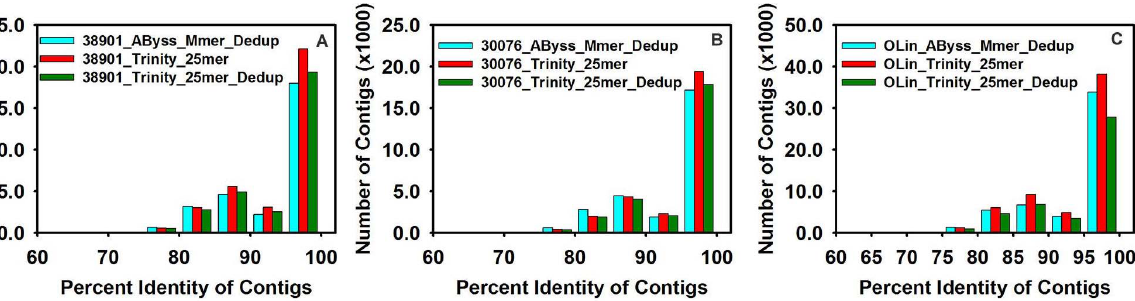
Fig. 3. Distribution of contigs with varying percent identity against the legume EST database. BLASTN searches were performed with the threshold value of 1 6 10 2 10 . A) 38901, B) 30076, C) Olin.